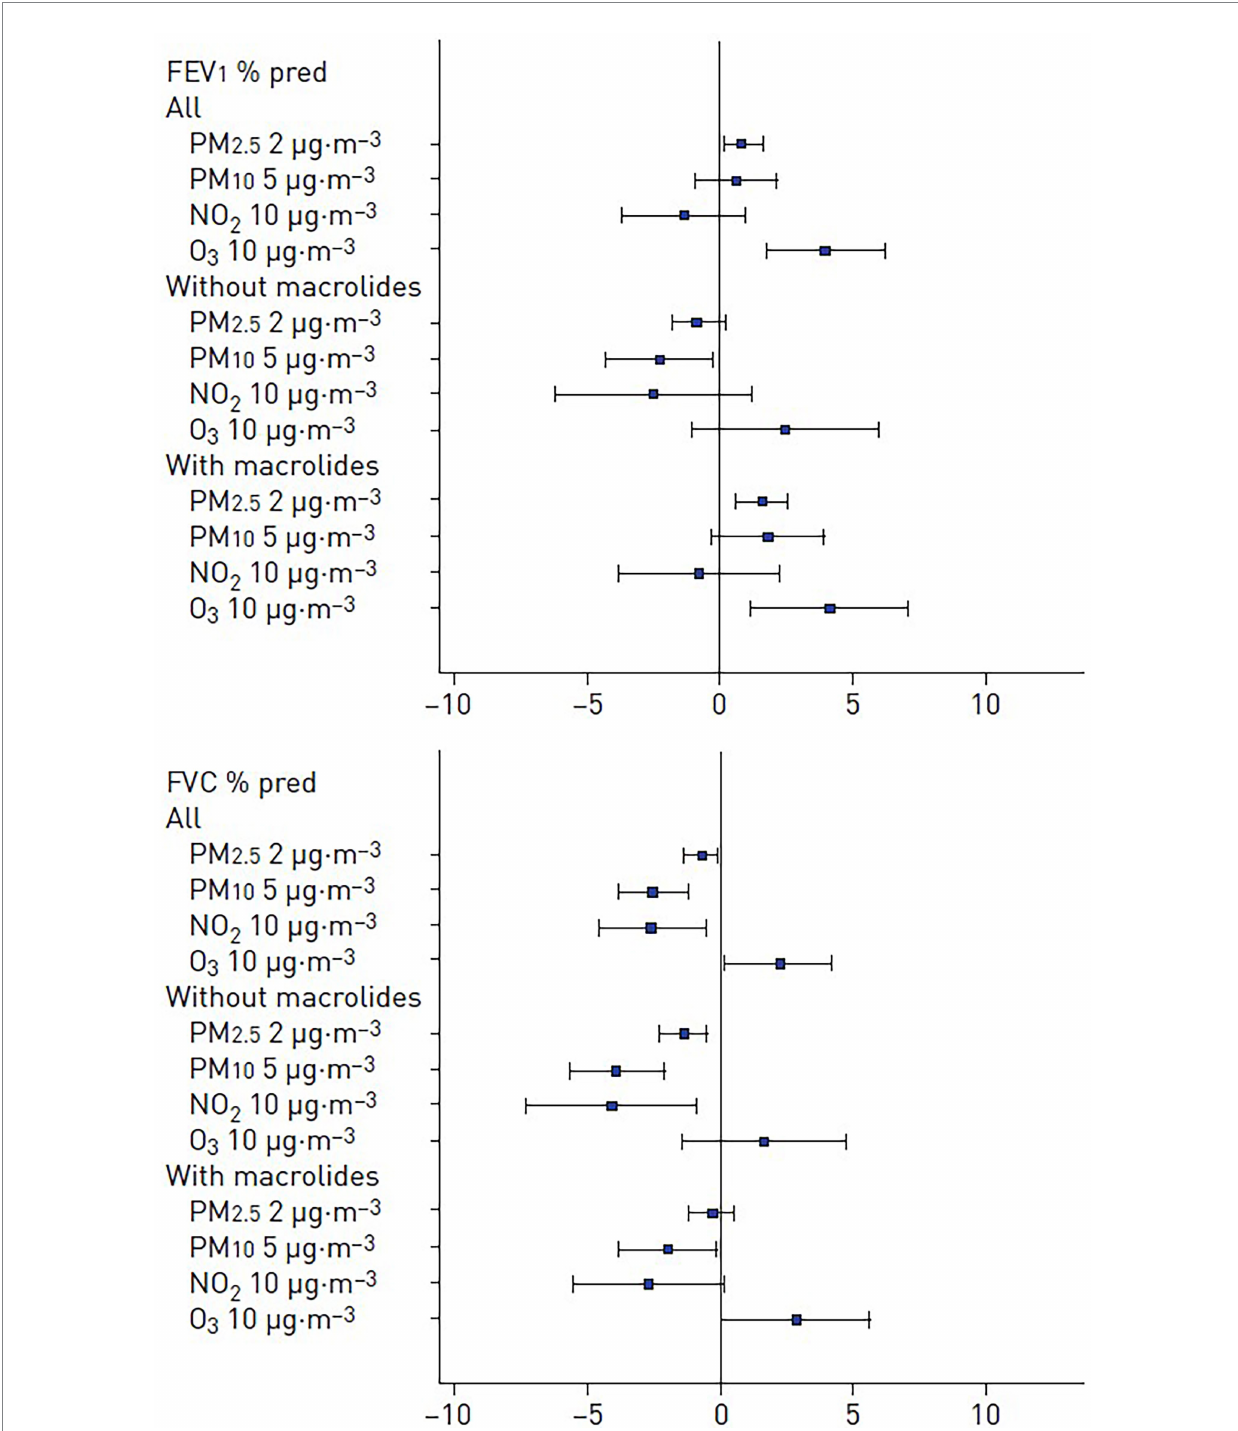
FIGURE 3 Adjusted associations between air pollutants exposure and level of (A) FEV 1 % predicted and (B) FVC% predicted in the whole population and according to the use of macrolides. PMx: particulate matter with an aerodynamic cross section of x μ m, adapted from